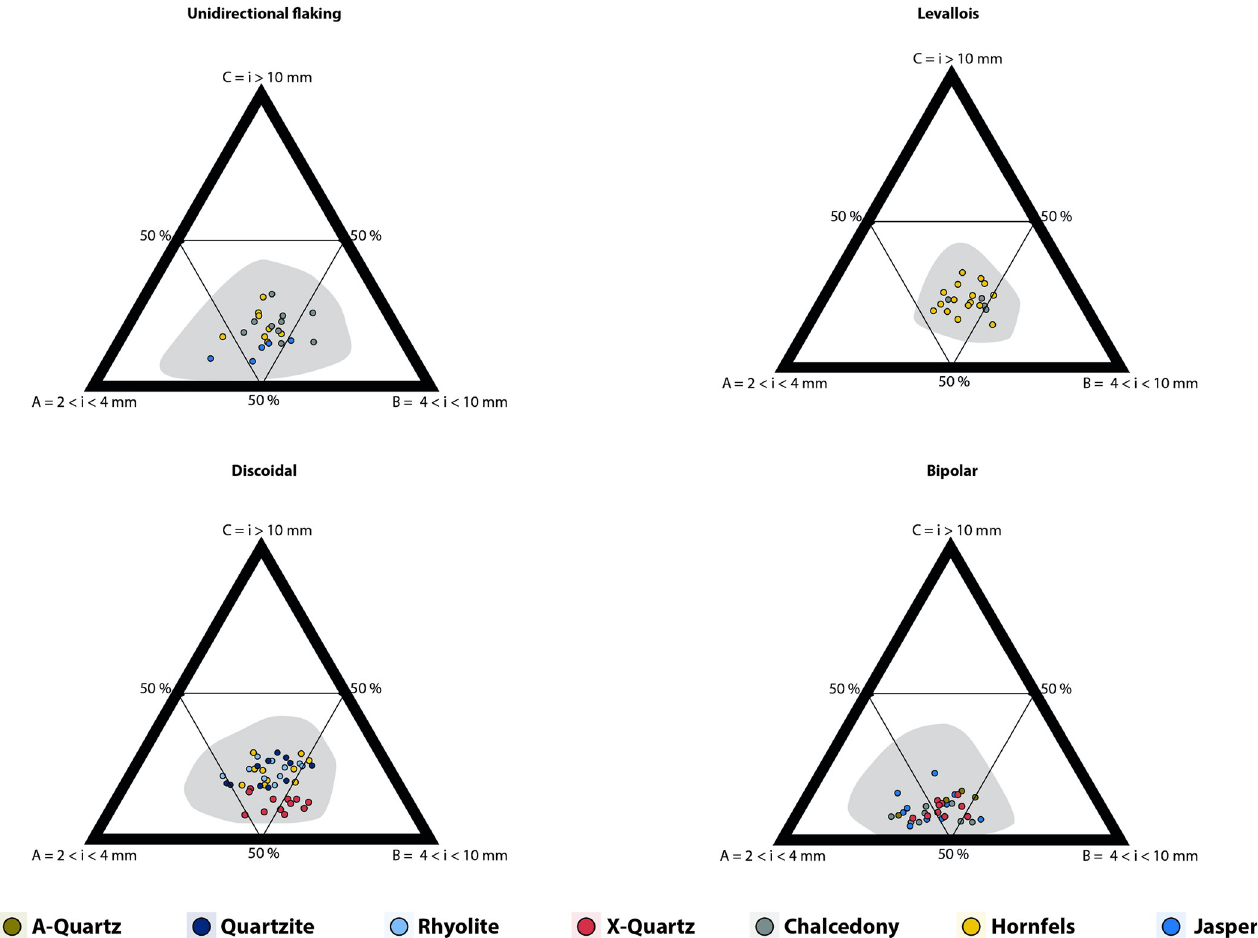
Fig 9. Ternary plots of the particle size distribution per knapping method (counts) in the SA dataset. Shaded areas are 95% confidence intervals.